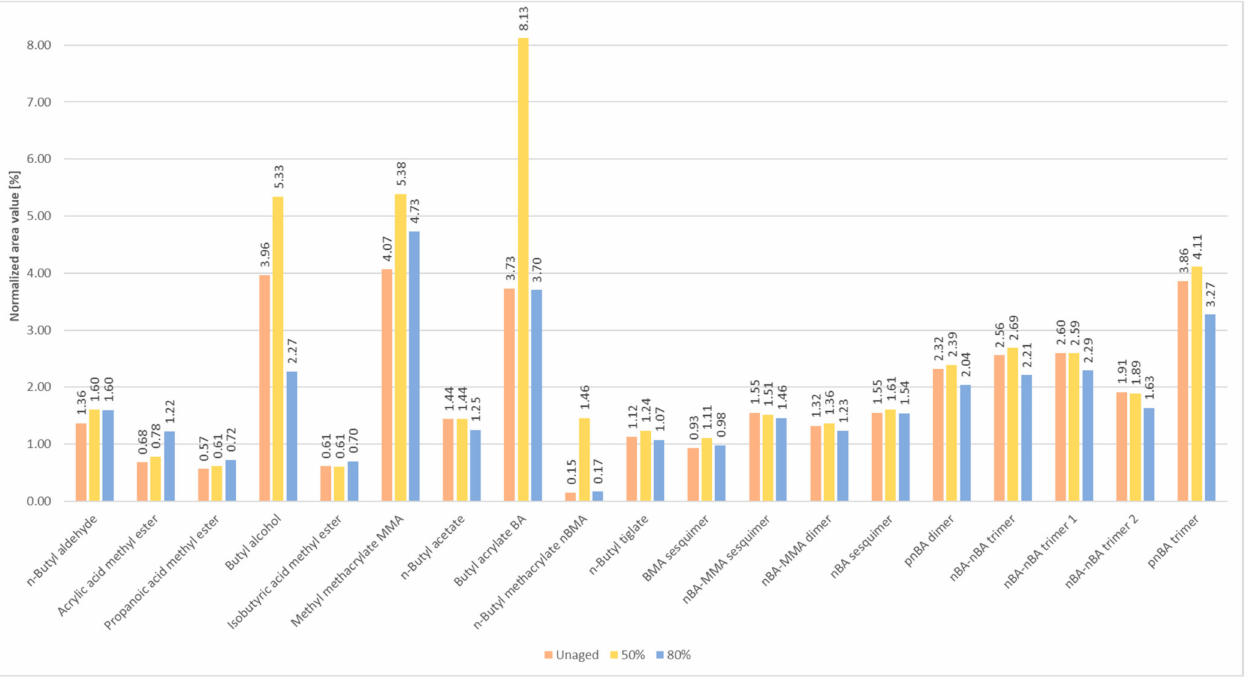
Figure A2. Integrated peak values of normalized areas divided for each compound identified by Py-GC/MS of the pure acrylic sample. Unaged (red), 50% RH (yellow), and 80% RH (blue) samples values are